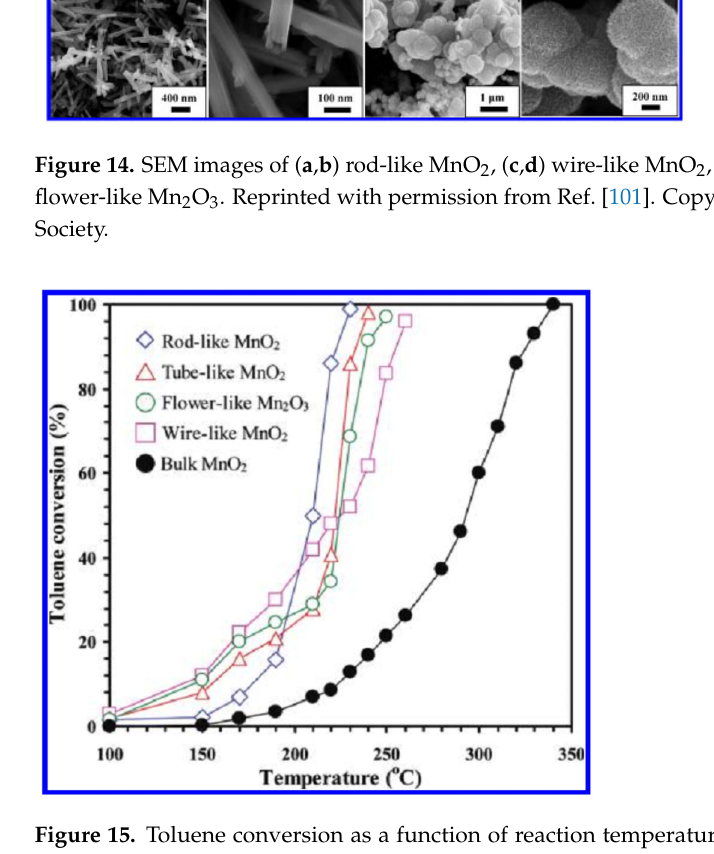
Figure 15. Toluene conversion as a function of reaction temperature over the catalysts under the conditions of toluene concentration = 1000 ppm, toluene/O 2 molar ratio = 1/400, and SV = 20,000 mL/(gh). Reprinted with permission from Ref. [101]. Copyright 2012 American Chemical Society. In reference [102], the synthesis of hollow and solid polyhedral MnO x was reported.